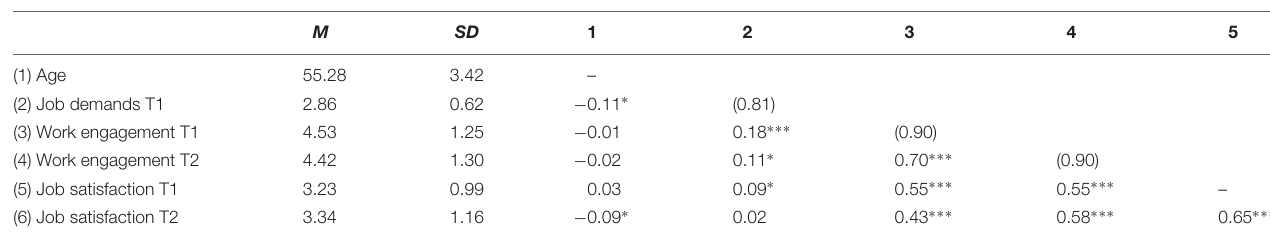
TABLE 1 | Mean, standard deviation, reliabilities (in brackets), and correlations between variables. M